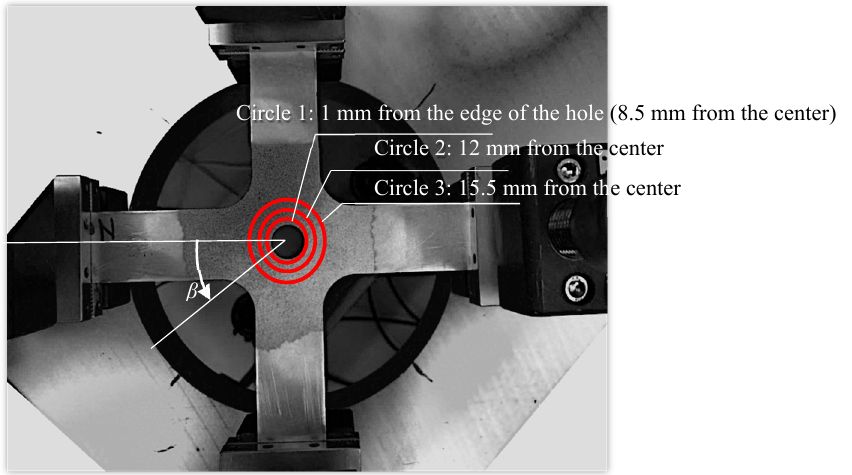
Figure 18. Location of circles the analyzed in the measurements.